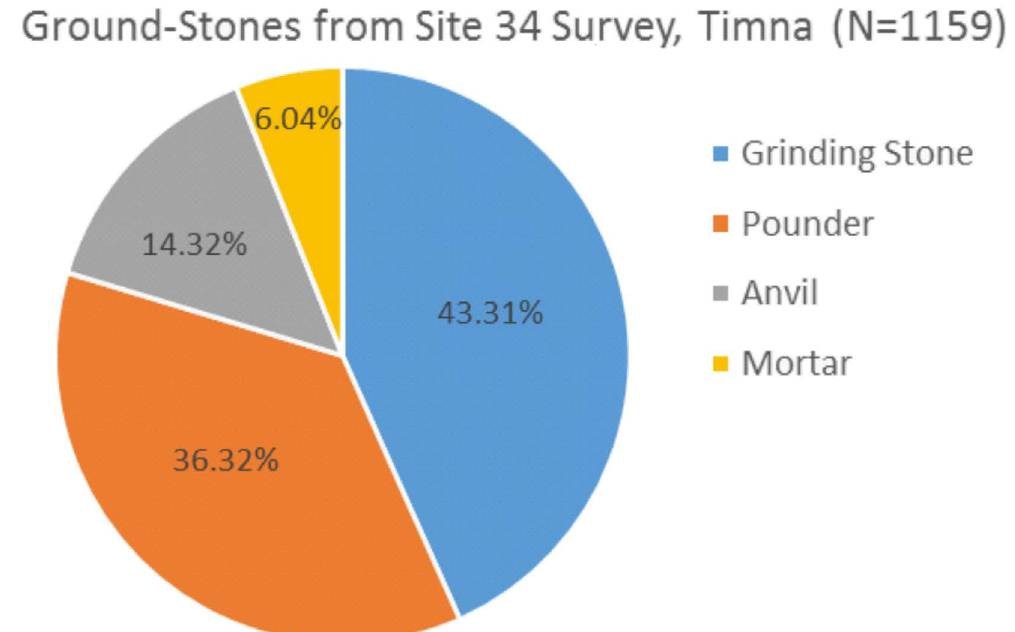
Figure 18. Rock type frequencies of ground stone from the Site 34 survey (unclassified tools not included).